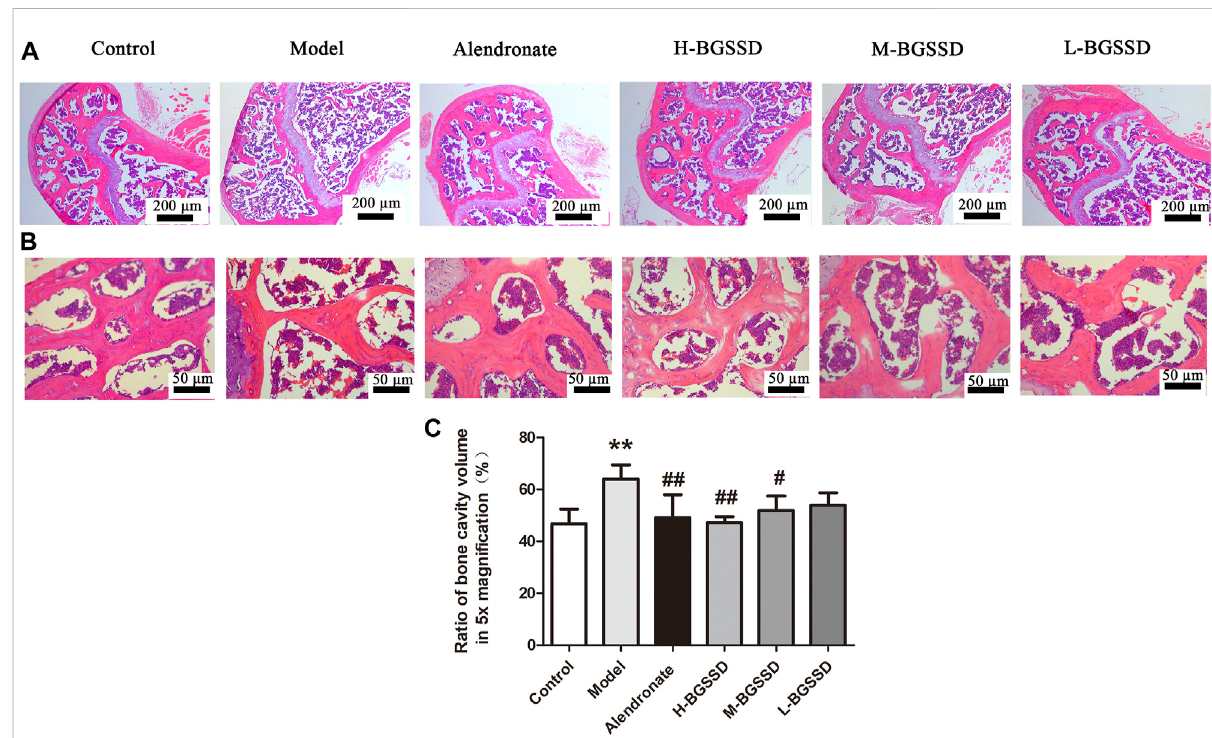
FIGURE 2 BGSSD ameliorated the bone tissue morphology of SAMP6. The femurs gathered from the above groups were performed by HE staining, the images of trabecular bone structure were selected from blow the growth plates, magni fi cation is ×5 (A) and ×20 (B). (C) Ratio of bone cavity volume regarding representative HE staining of femoral sections from different groups in ×5 magni fi cation, the site of choice was selected from blow the growthplates.Dataareexpressedasmean±SD,** p < 0.01,comparedwiththecontrolgroup; # p < 0.05, ## p < 0.01,versusthemodelgroup.All assays were repeated more than three